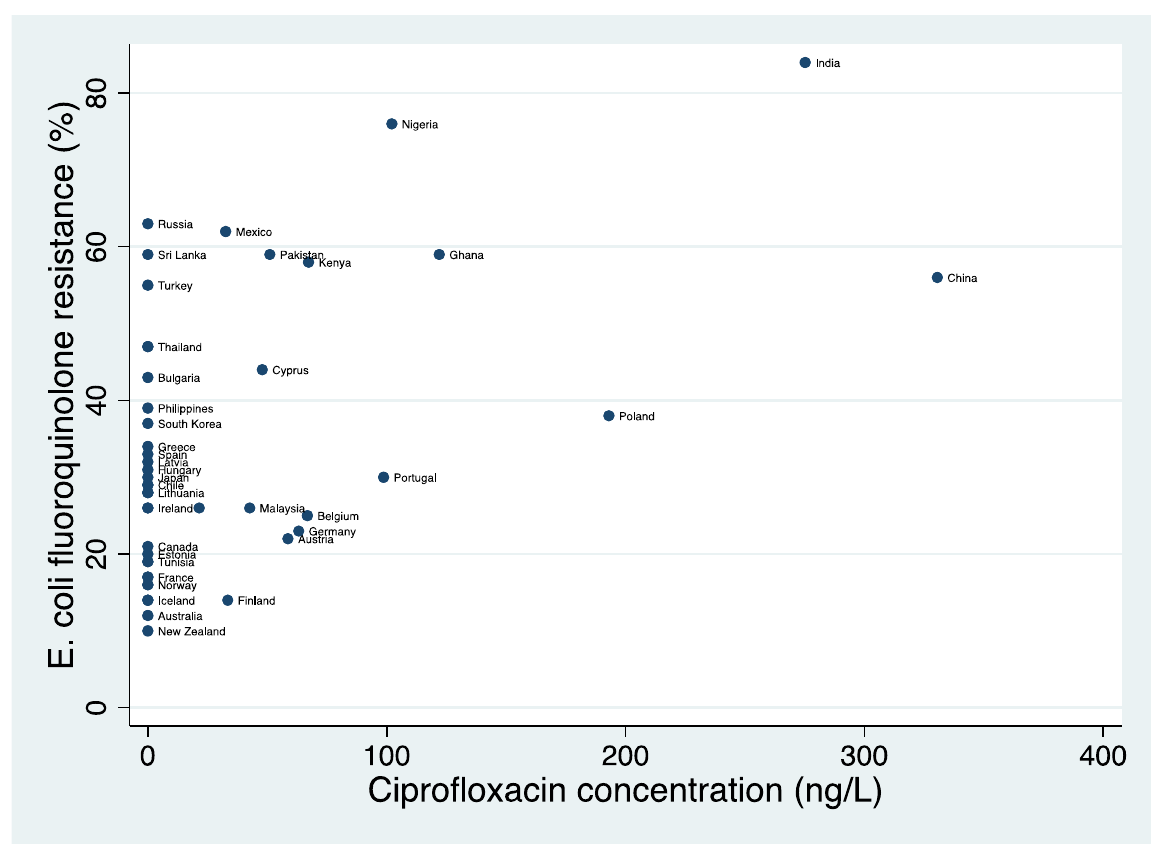
Figure 1. Scatter plot of national median concentration of ciprofloxacin in rivers (ng/L) versus prevalence of Escherichia coli fluoroquinolone resistance (%).